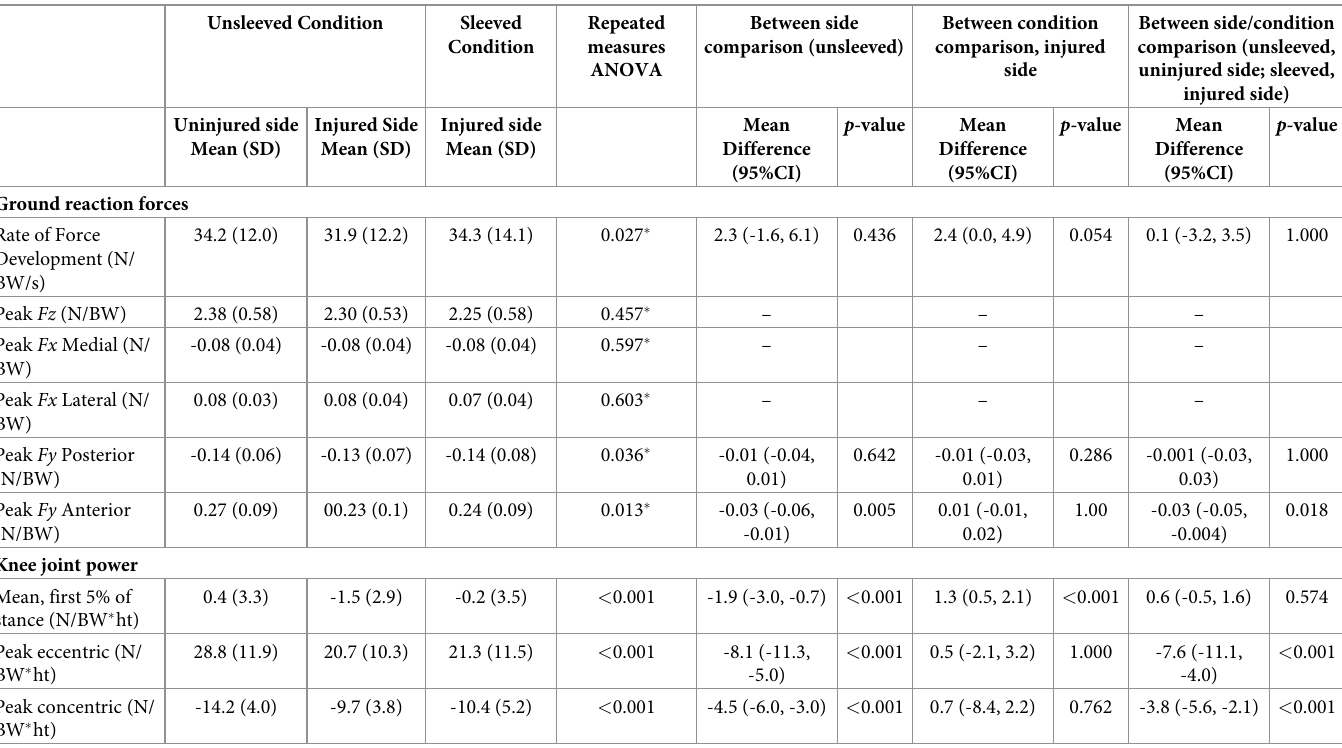
Table 2. Immediate effects of wearing the sleeve: Cross-over trial (n = 30).